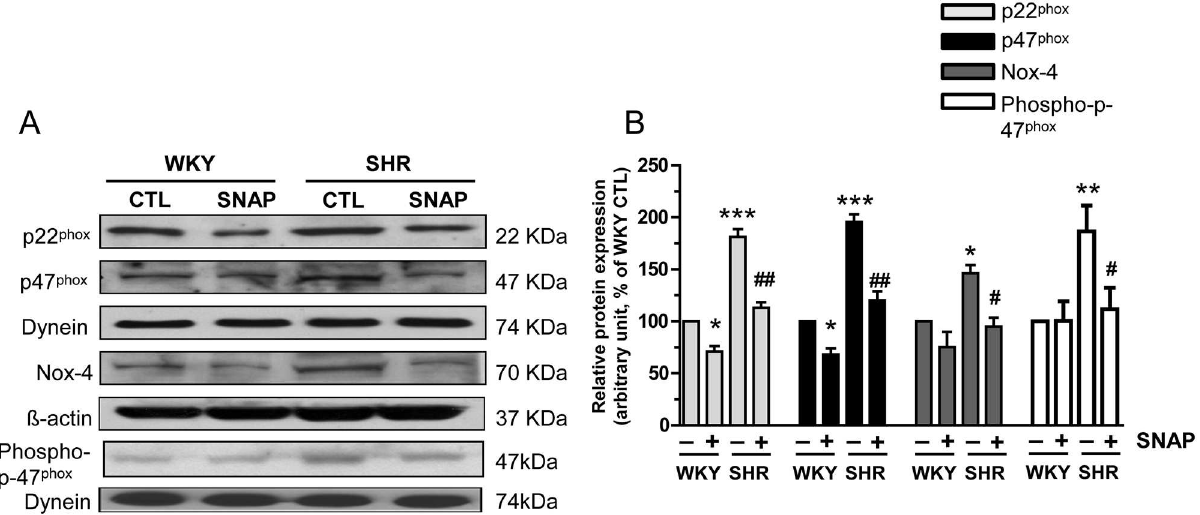
Fig 6. Effect of SNAP on the expression of NADPHoxidase subunits in aortic VSMC from 12-weekold SHRs and age-matched WKY rats. ConfluentVSMC were incubatedin the absence(control) or presenceof SNAP (100 μ M) for 24 h. The cell lysates were prepared and subjectedto Western blot analysisusing specific antibodies againstNADPH oxidasesubunitsp22phox, p47phox,phospho-p47phox and Nox-4 (A) as describedin Materials and methods. Dyneinwas used as a loadingcontrol for p22phox, p47phoxand phospho-p47phox whereas β -actin was used as loadingcontrol for Nox-4. Quantification of protein bandswas done by densitometric scanning(B). The results are expressedas a percentage of the WKY control (CTL), taken as 100%. Values are the mean ± SD of 4 separate experiments using different cell populations from different animals. * P < 0.05, ** P < 0.01, *** P < 0.01 vs WKY CTL group; # P < 0.05, ## P < 0.01 vs SHR CTL group.